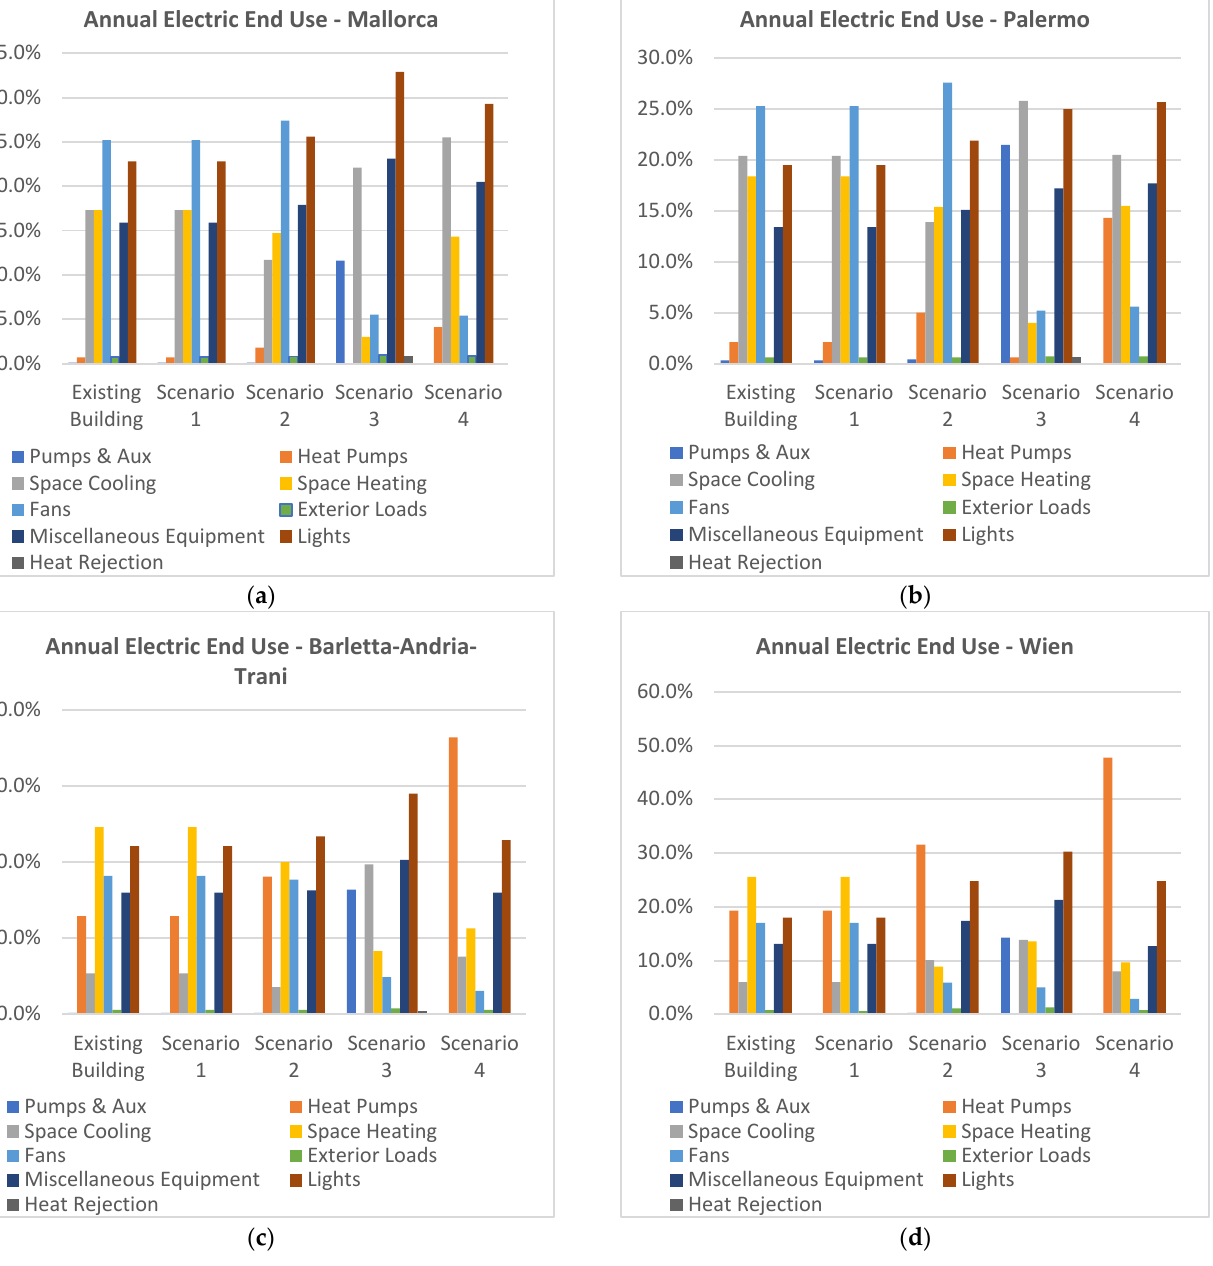
Figure 8. Annual Electric End Use ( a ) in Mallorca, ( b ) in Palermo, ( c ) in Barletta-Andria-Trani, and ( d ) in Wien.